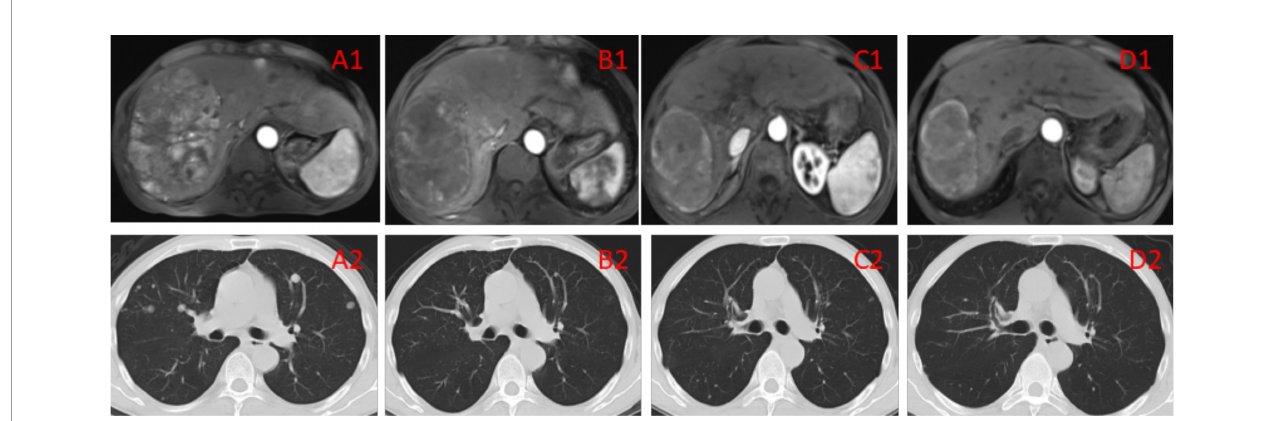
FIGURE 5A1 – D2 | (A1, A2) Imaging manifestations of the patient before the treatment, showing a massive tumor accompanied by multiple small lesions in the right lobe of the liver, as well as multiple metastatic lesions in bilateral lungs. BCLC liver cancer stage: IIIB. (B1, B2) Imaging manifestations of the patient after 2 TACE sessions and 3 cycles of immunotherapy, showing the tumor in the right lobe of the liver with evident necrosis compared with the pretreatment condition as well as reduced number and sizes of multiple metastatic lesions in bilateral lungs. The ef fi cacy evaluation showed PR. (C1, C2) Imaging manifestations of the patient after 4 TACE sessions and 6 cycles of immunotherapy, showing that the lesion in the right lobe of the liver was generally necrotic, as well as overtly reduced number of lesions in bilateral lungs. The ef fi cacy evaluation showed PR. (D1, D2) Imaging manifestations of the patient after 12 cycles of immunotherapy, showing that the lesion in the liver was generally necrotic, with no lung lesions. The ef fi cacy evaluation showed CR.